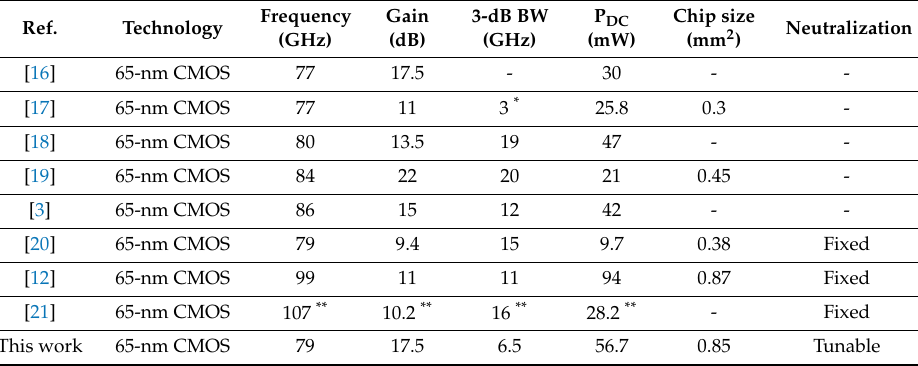
Table 1. Performance summary and